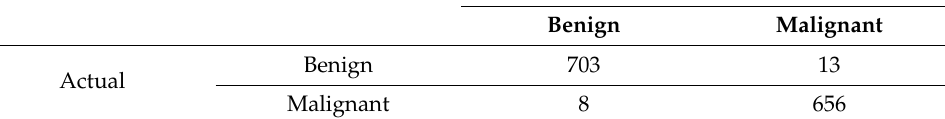
Table 2. Summary of evaluation index for image classification.